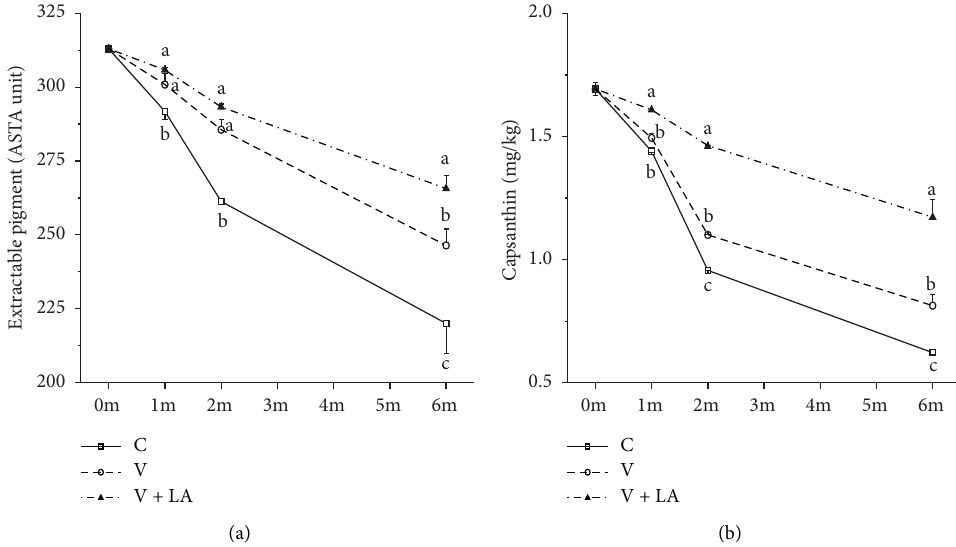
Figure 2: Infuence of diferent packaging on ASTA unit (a) and capsanthin content (b) of the dried whole chili during storage. C: control with polyamide/polyethylene flm; V : vacuum packaging with polyamide/polyethylene flm; V +LA: vacuum and light-avoided packaging with aluminum polyethylene flm. ASTA: American Spice Trade Association. a–c represent the signifcant diference ( P < 0 . 05) of dried pepper stored in diferent